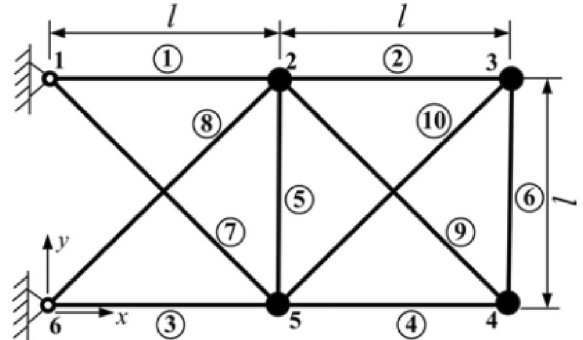
Figure 10. Schematic view of the ten-bar truss problem 66 .